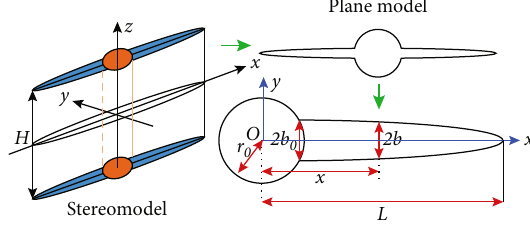
in carbon dioxide displacing coal seam. 4